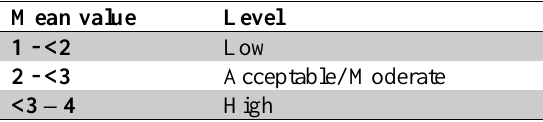
Table 2. Students’ Readiness Scale